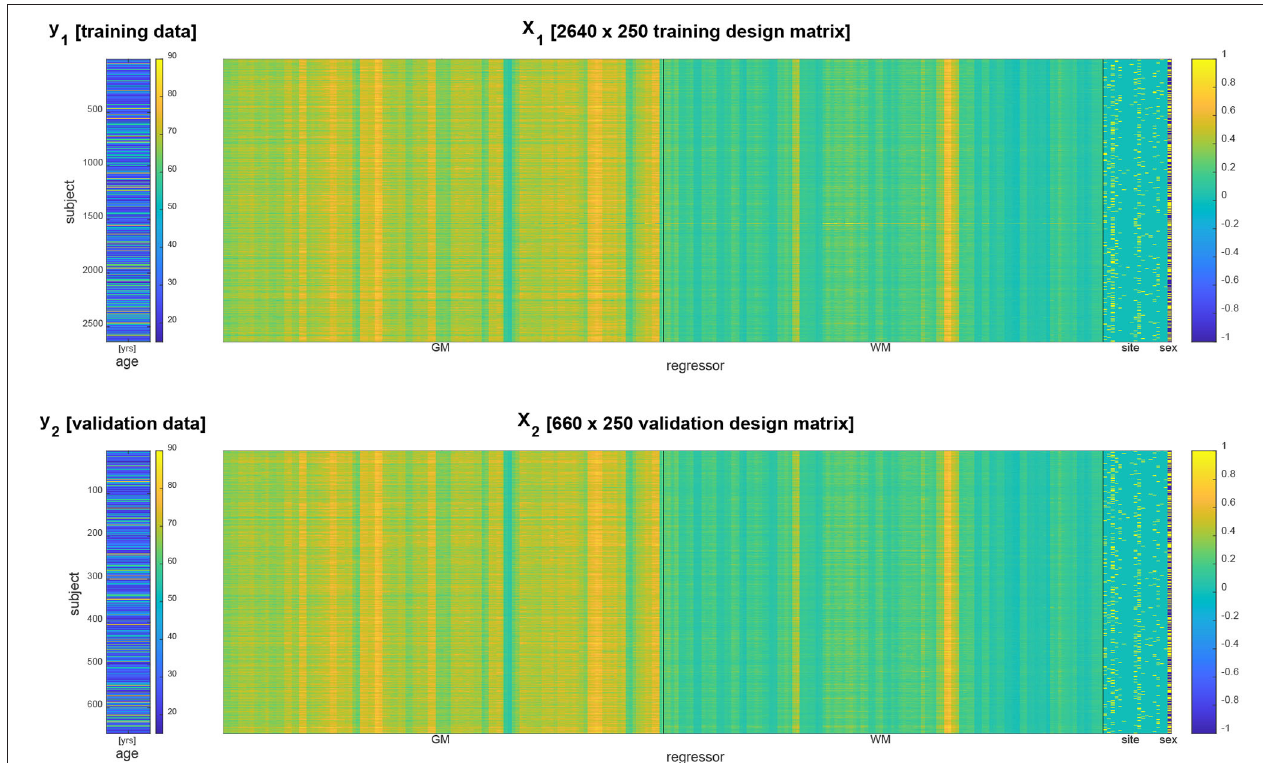
FIGURE 1 | Data vector (left) and design matrix (right) for training set (top) and validation set (bottom) . In the design matrices, rows correspond to subjects and columns correspond to brain regions and covariates. Regressors specifying gray matter (GM) and white matter (WM) densities as well as site covariates are separated by vertical black lines.